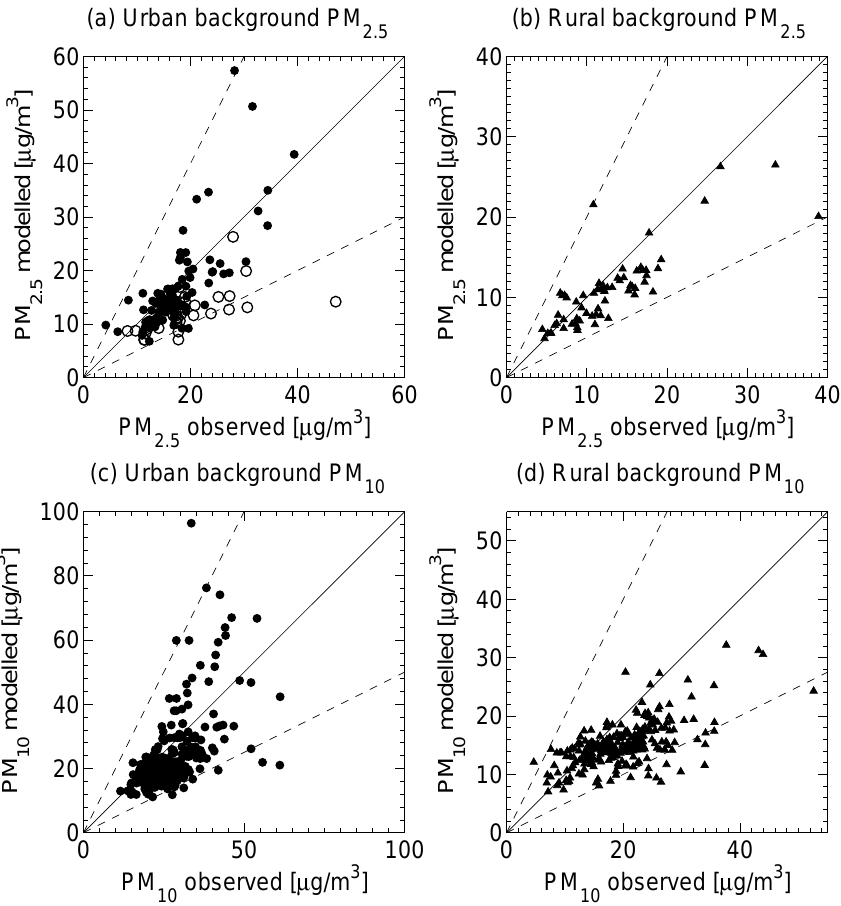
Figure 5. Bottom up calculated vs. observed PM 2 . 5 and PM 10 concentrations at urban and rural background monitoring stations in 2009. Panel (a) distinguishes into stations located in cities > 100000 inhabitants (dots) and those not (circles). For better viewing, only urban stations in cities > 100000 inhabitants are shown for PM 10 (c)